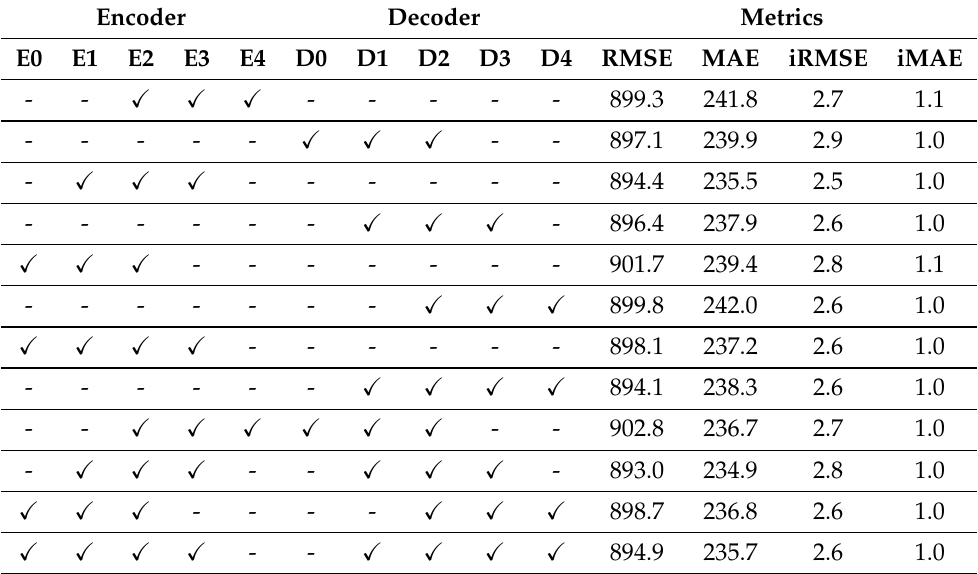
Table 3. Performance comparison with various combinations of layers for the distillation on the KITTI DC validation dataset [32]. Encoder Decoder